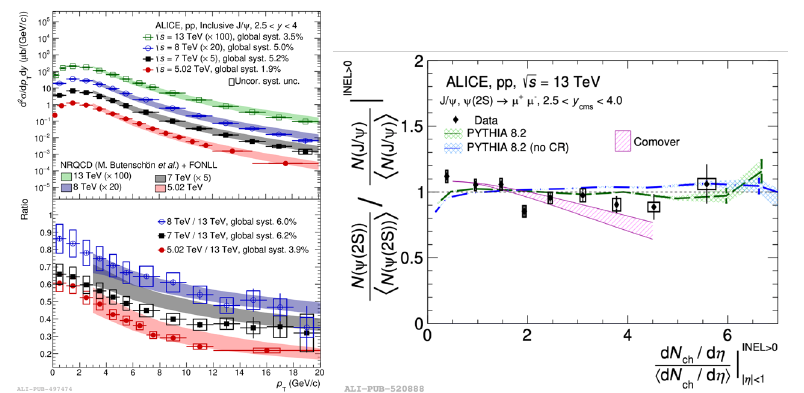
Figure 1. (left) The inclusive J / ψ p T -di ff erential cross section (top), and the ratio of the 5.02, 7, and 8 TeV cross sections to the 13 TeV one (bottom), at forward rapidity, in pp collisions [7]. (right) The self- normalised ψ (2S)-to-J / ψ yield ratio measured at forward rapidity as a function of the charged particle multiplicity measured at midrapidity, in pp collisions at √ s = 13 TeV [9].